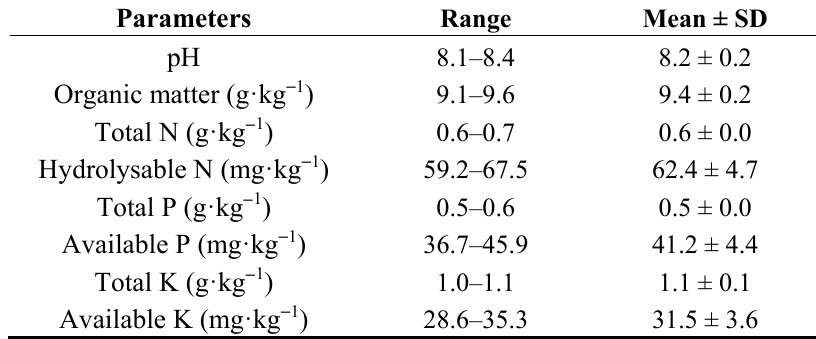
Table 1. Baseline soil information for the experimental site in Taixing, Jiangsu Province, China. Soil samples were collected in the 15 experimental plots at the initiation of the study (March 2004) from depths of 0–20, 20–40, and 40–60 cm. SD is standard deviation ( n =